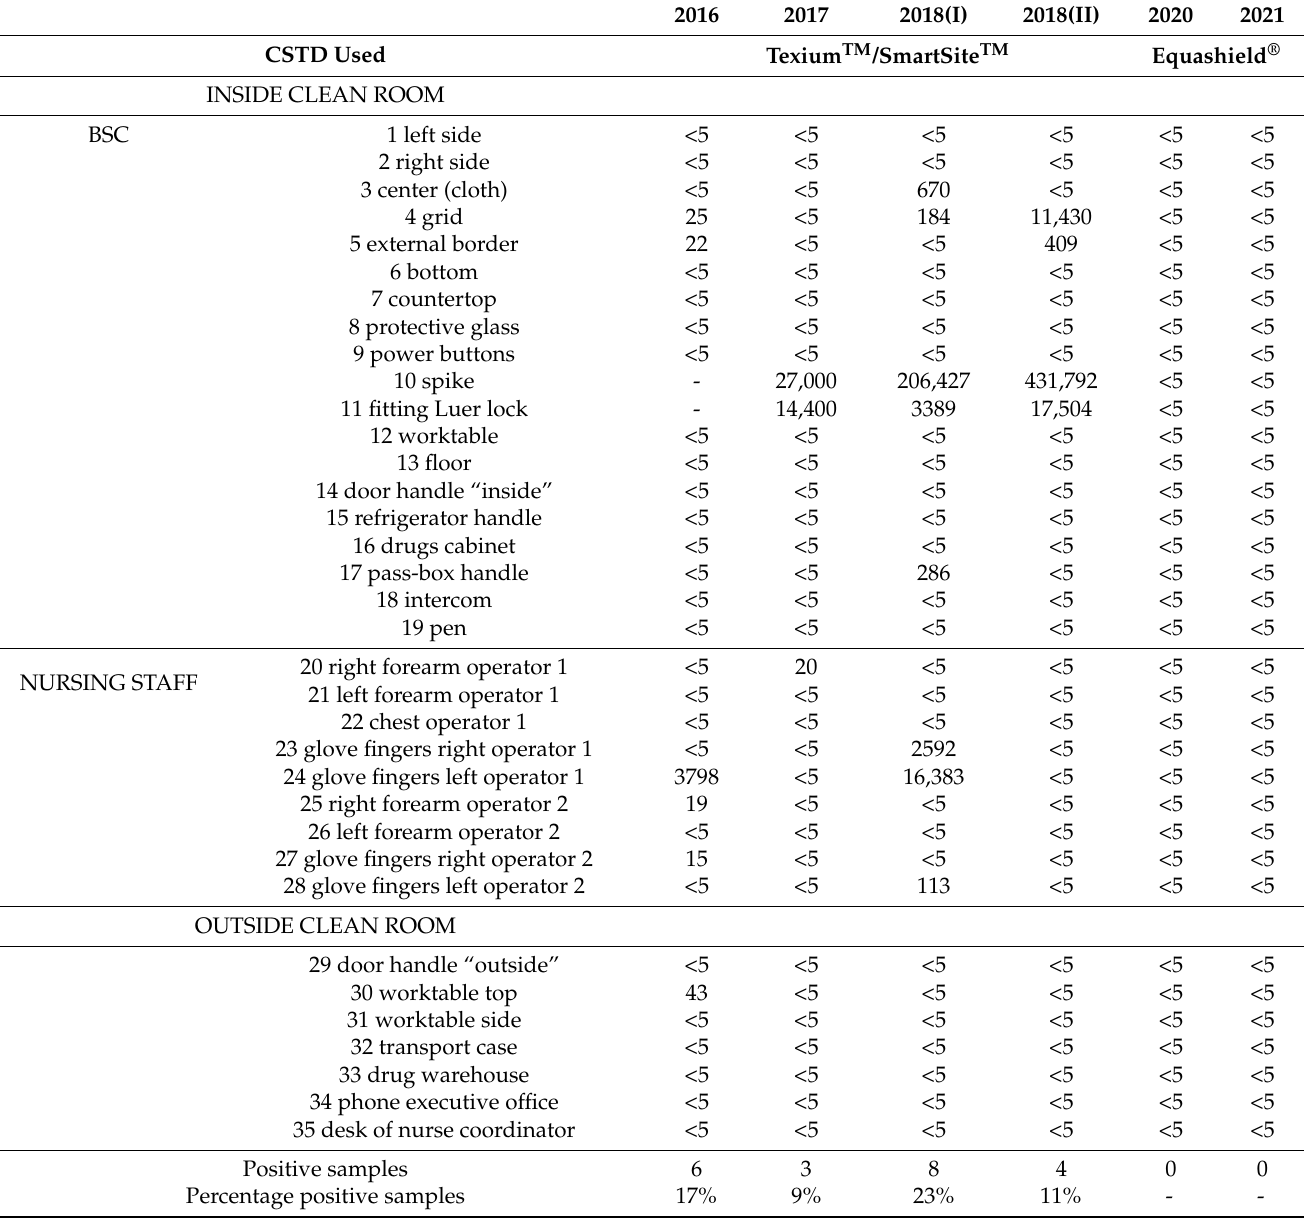
Table 1. Results of GEM concentrations (ng/wipe) in wipe/pad samples during the monitoring programs from 2016 to